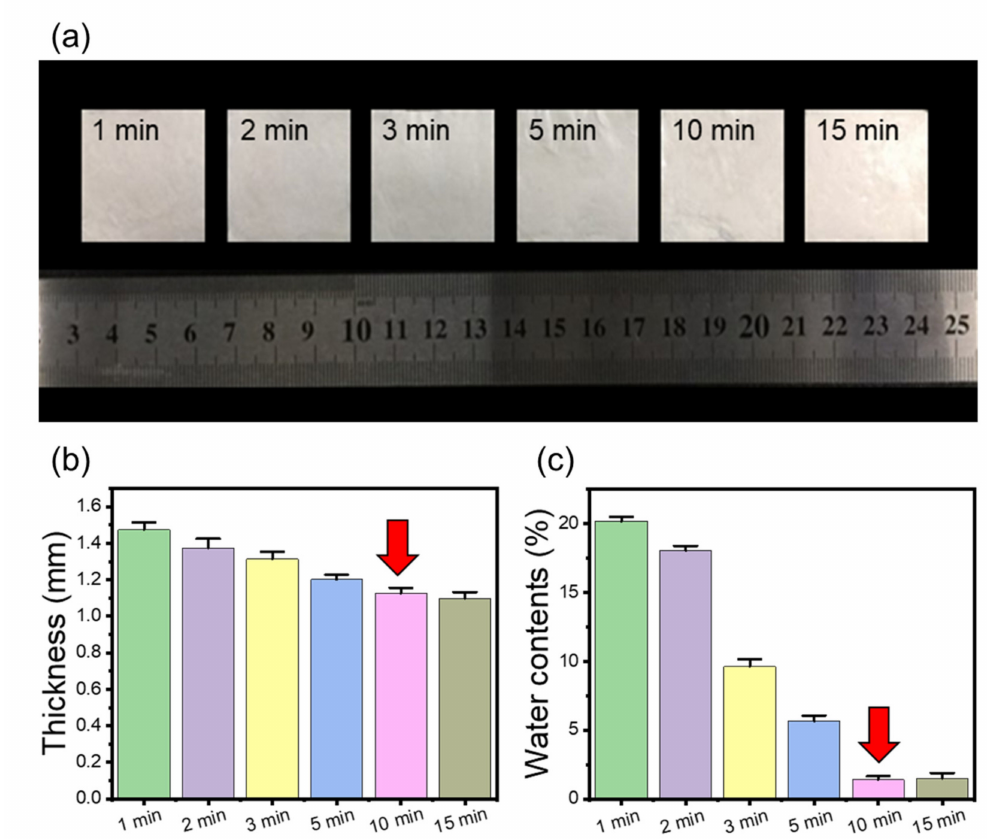
Figure 3. Effect of thermocompression time on the physical properties of BF/CNF fibrous preforms. ( a ) Optical images, ( b ) thickness, and ( c ) water contents of BF/CNF fibrous